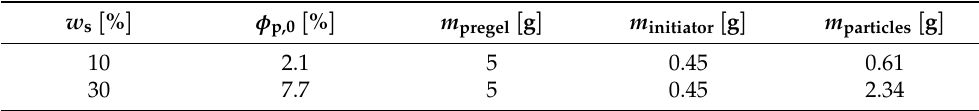
Table 1. Composition of synthesized magnetorheological gels. w s and φ p,0 denote the mass and volume fraction of the particles in the initial state of